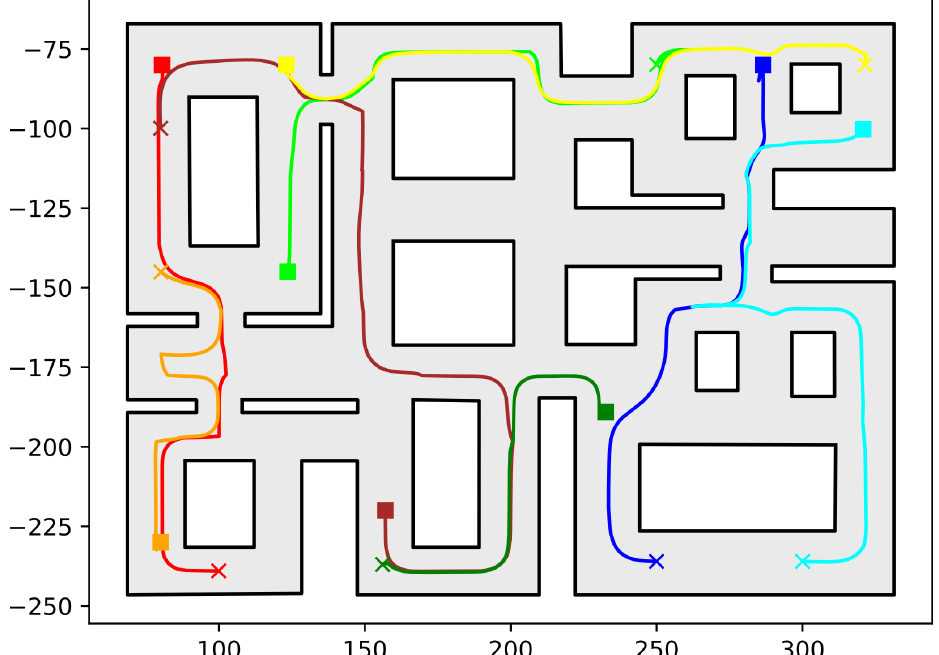
Figure 8. Executed trajectories of the eight-robot case. Squares indicate initial positions, whereas the corresponding goal positions are depicted using crosses. Robot #1 (red); Robot #2 (green); Robot #3 (dark red); Robot #4 (orange); Robot #5 (yellow); Robot #6 (dark green); Robot #7 (blue); Robot #8 (cyan). The axes units are in